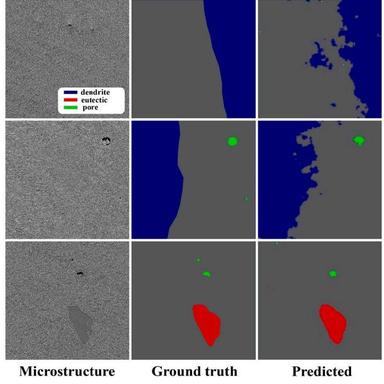
Recognized results using U-Net model compared with labeled images.